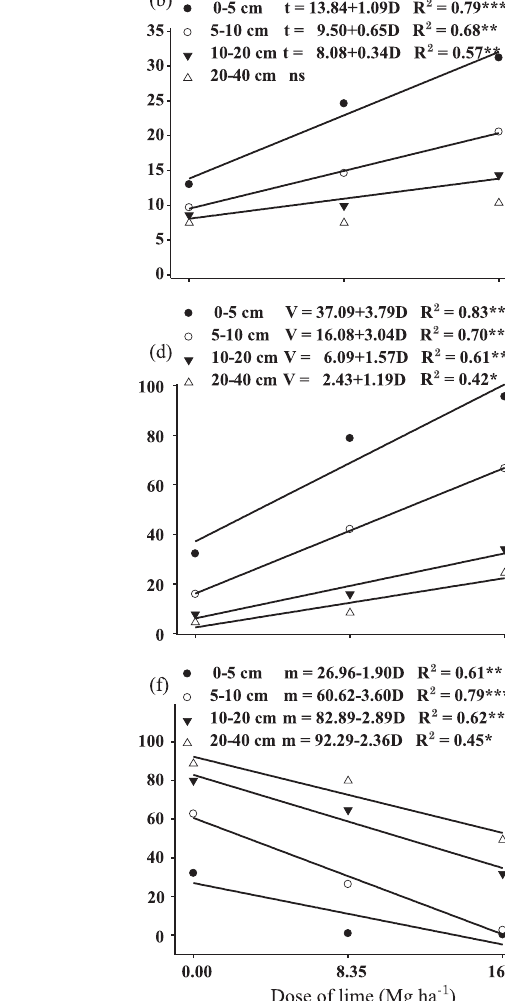
figure 3. effective cec (t), base saturation (V) and aluminum saturation (m) in the layers of a humic cambisol amended with doses (d) of dregs (a, c, e) and lime (b, d, f), applied to the soil surface in 2004/2006. Bocaina do sul, sc, 2009. (*, **, *** and ns: significant at 5, 1, 0.1 % and not significant,